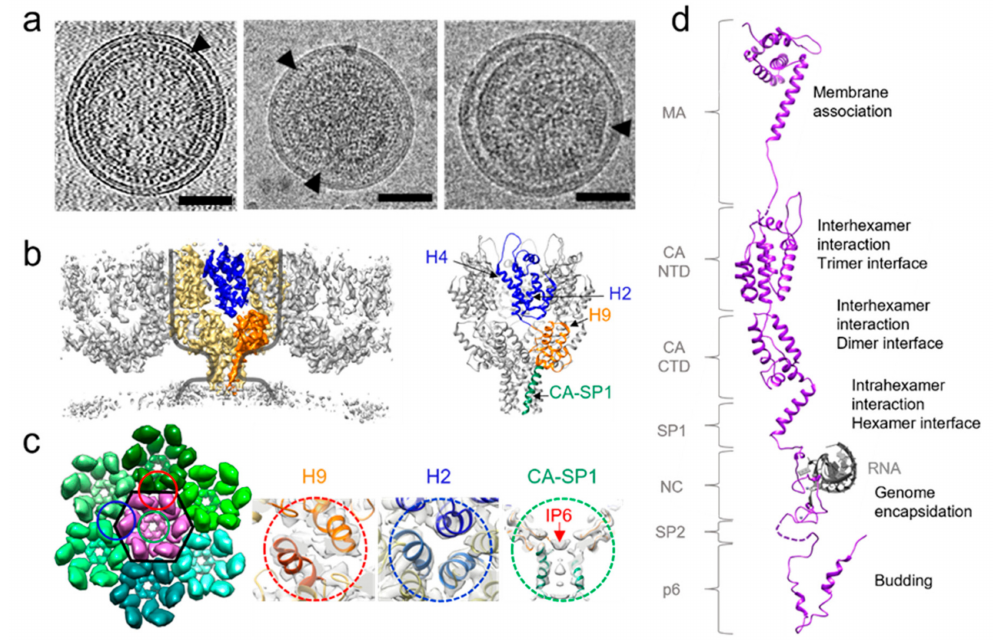
Figure 1. Retroviral immature lattice organization. ( a ) Tomographic slice of an HIV-1 (left), and cry- oEM images of RSV (center) [15] and HTLV-1 (right) [15] virus-like particles, black arrowheads point to Gag lattice. Scale bars, 50 nm. ( b ) HIV-1 immature Gag structure, shown as cryoET subtomoram averaging map (left) and atomic model of the hexamer (right). One hexamer is highlighted in yellow in cryoET STA map within which one monomer is colored in blue (NTD) and orange (CTD and SP1). Grey outline shows the wine glass profile of the Gag hexamer [27]. ( c ) HIV-1 immature lattice organization in top view. Details of the dimeric, trimeric and hexameric interfaces are shown in gold, blue and green dashes, respectively. ( d ) HIV-1 Gag polyprotein domain organization. Original